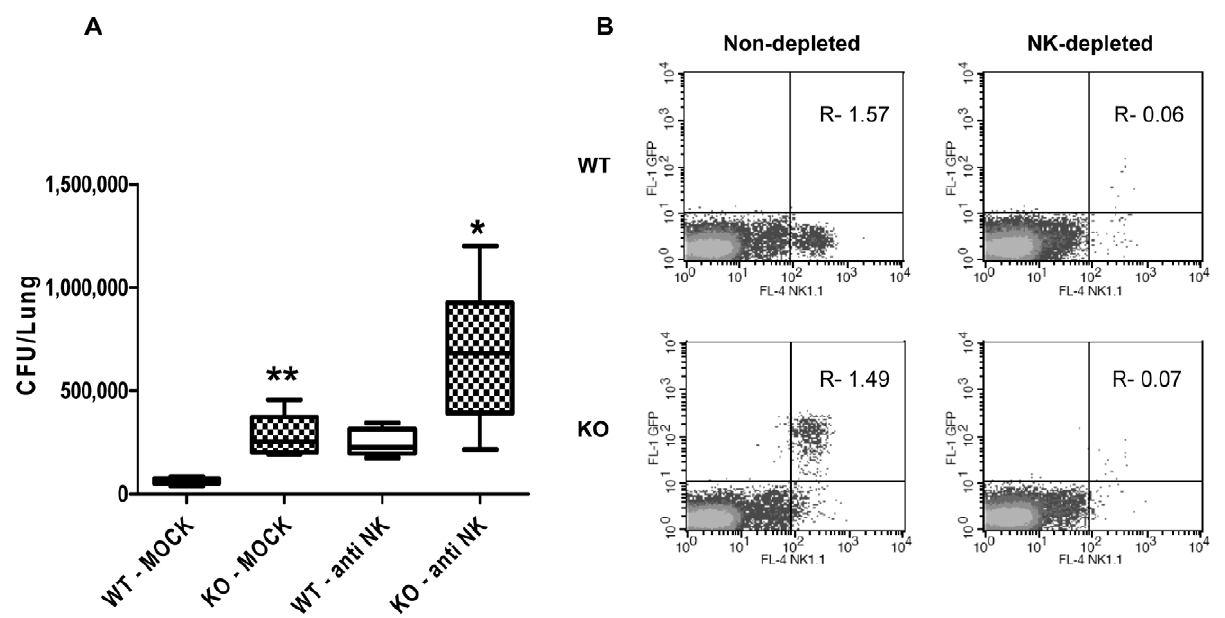
Figure 4. Bacterial load in lungs following invivo depletion of NK cells . Ncr1 + / + and Ncr1 gfp/gfp C57BL/6 mice treated intraperitoneally either with 50 m l of anti asialo GM1 (WT-anti NK and KO-anti NK) or with 50 m l of PBS (mock treatment, WT-mock and KO-mock). 24 h after anti asialo GM1 or mock treatment, all mice were challenged with 5 6 10 7 CFU of S. pneumoniae strain WU2 and lungs were harvested 3 h after challenge. (A) CFU of S. pneumoniae in lungs, 3 h after bacterial challenge (n=3 to 5 per group). Results are presented as box plot of CFU. ** p , 0.01 compared with WT- mock; * p , 0.05, compared with WT-anti NK, 6 SD (ANOVA test). (B) Flow cytometry analysis of spleen cells from depleted and non-depleted mice for CD3 negative-gated cell population showing NK1.1 versus GFP expression. Analysis was made 24 h after depletion and 3 h following bacterial challenge (representative mouse per each panel). Numbers indicate percentage of gated cells (LR + UR) from CD3 2 cells. Results are from one representative experiment of